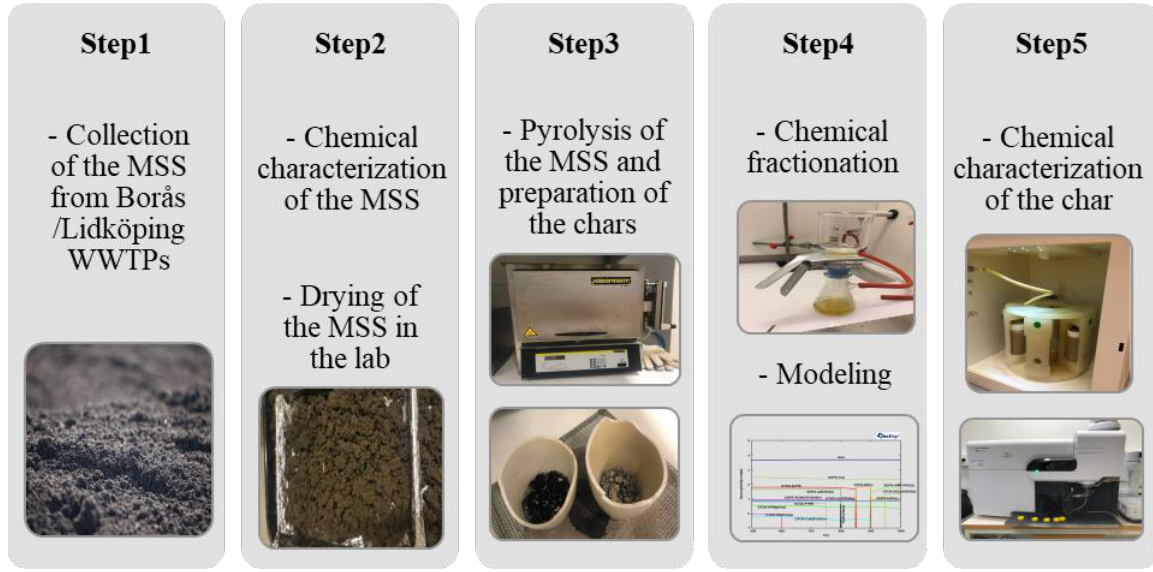
Figure 1. Schematics of the steps in the current study.